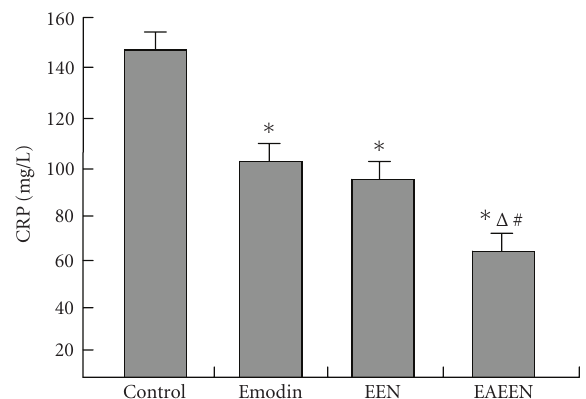
Figure 5: Changes of serum CRP levels in di ff erent groups. ∗ P < . 05 versus control group; Δ P < . 05, EAEEN group versus Emodin group; # P < . 05, EAEEN group versus EEN group. EEN: early enteral nutrition. EAEEN: emodin-assisted early enteral nutrition. CRP: C-reactive protein.